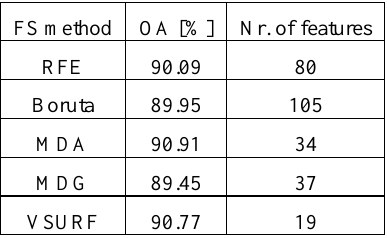
Table 4. Peak overall accuracy (%) for Random Forest